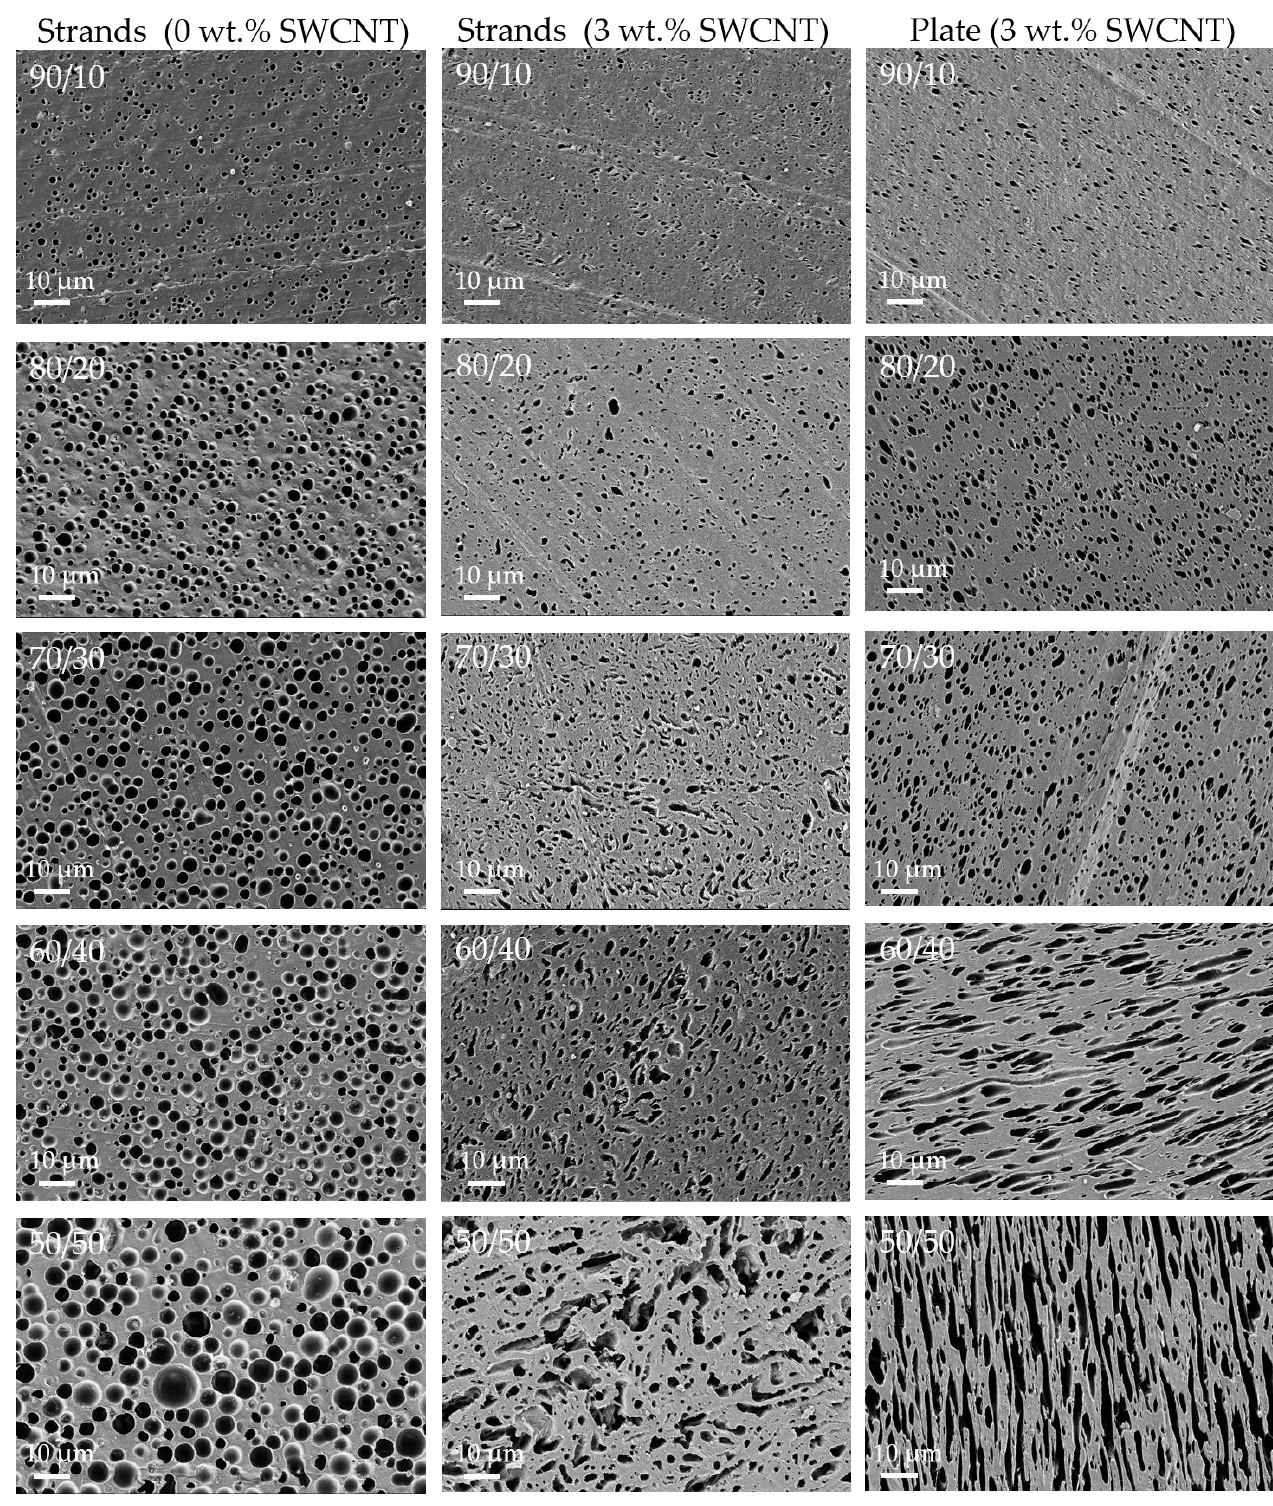
Figure 7. SEM images of etched flat surface of PA6/SAN blends with different blend ratio from 90/10 ( first line ) up to 50/50 ( last line ) and different kinds of sample such as strands without CNTs ( left ), strands with 3 wt.% CNTs ( middle ), and compression-molded plates with 3 wt.% CNTs ( right ).